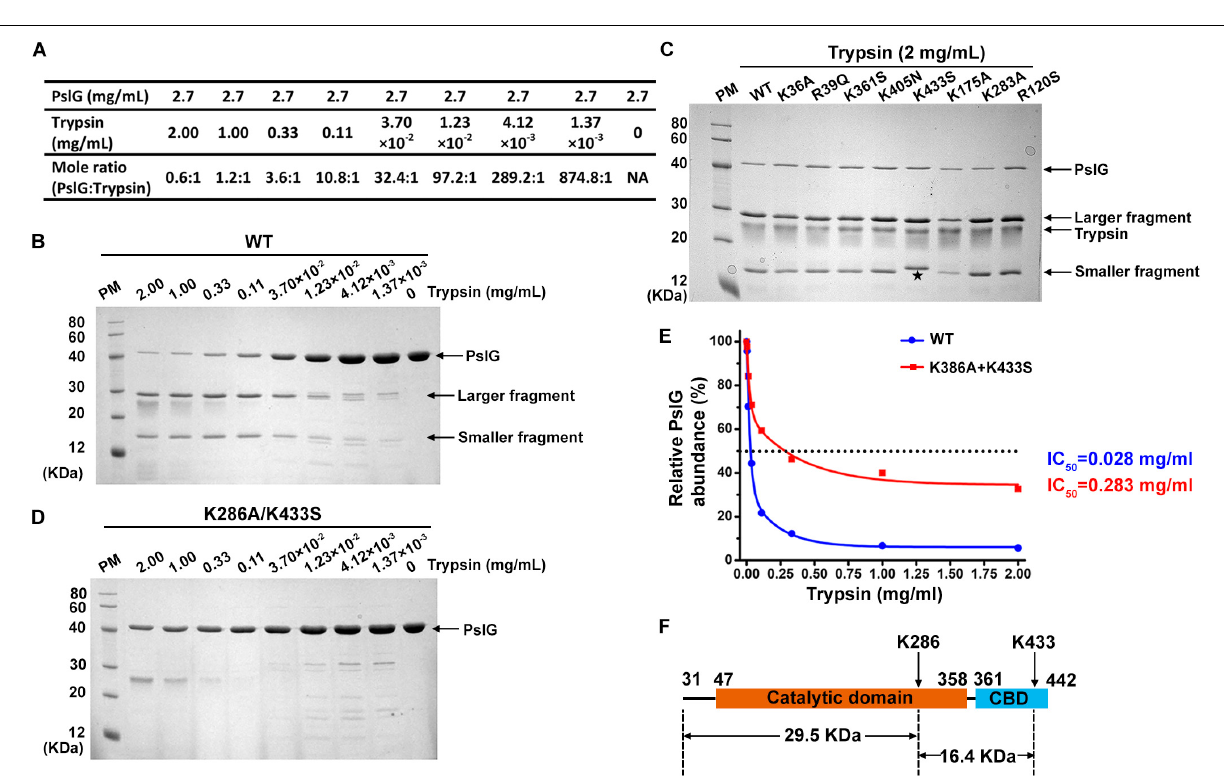
K283A did not affect the proteolysis of PslG ( Figure 3C ),